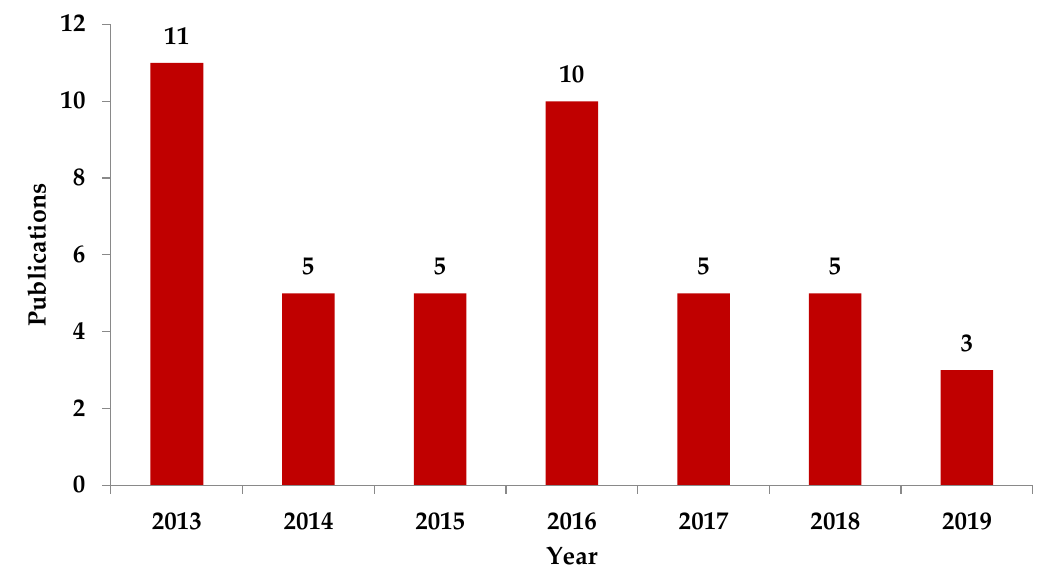
Figure 19. A representation of the total number of publications for VPP optimization scheme in recent years.